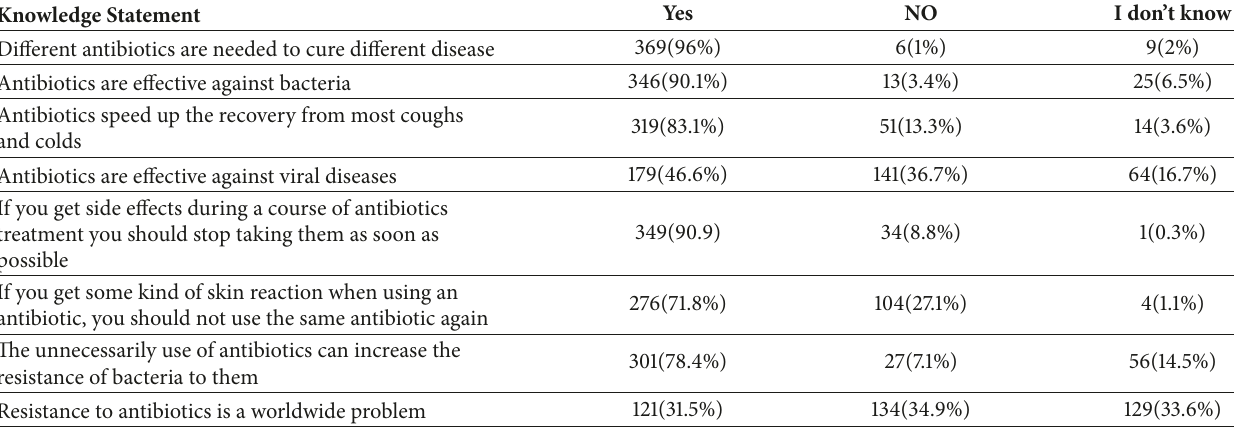
Table 2: Knowledge towards use of antibiotics among Harar city and its surrounding residents, February 1 to May 1, 2017 (n = 384).